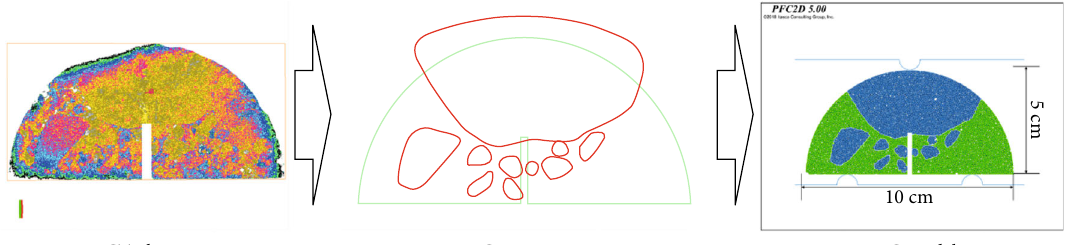
Figure 9: Modeling process. After selecting the CT layer with a speci fi c thickness position, the outline of the gravel is drawn using the CAD software and fi nally imported into PFC2D to form a model.